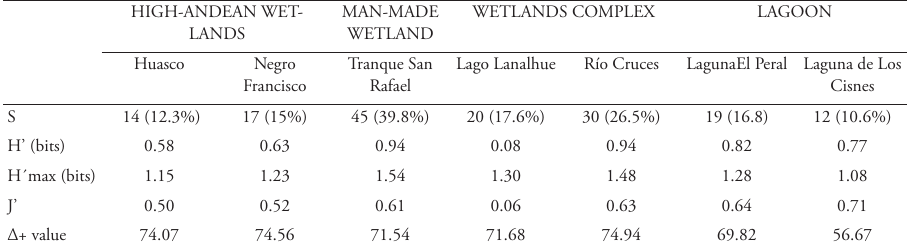
Table 4. α diversity in four types of wetlands in Chile. S= species richness, H´= Shannon-Wiener Index. H’max.= Max. value of Shannon-Wiener Index. J= Pielou’s evenness index. Δ+ = Mean taxonomic dis-